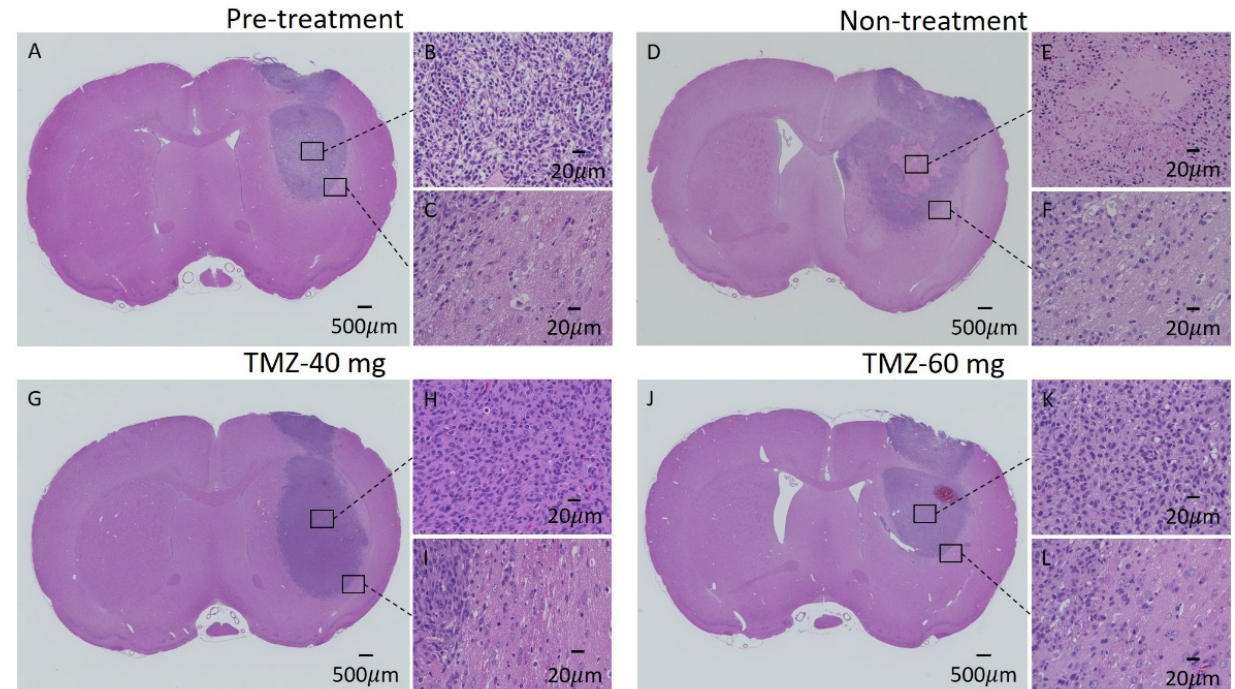
Figure 7. HE staining images of individuals in the pre-treatment group on day 7 and the non-treatment, TMZ-40 mg, and TMZ-60 mg groups on day 14. ( A,D,G,J ): Black bars equal 500 μm. ( B , C , E , F , H , I , K,L ): 20 μm. HE, hematoxylin and eosin.